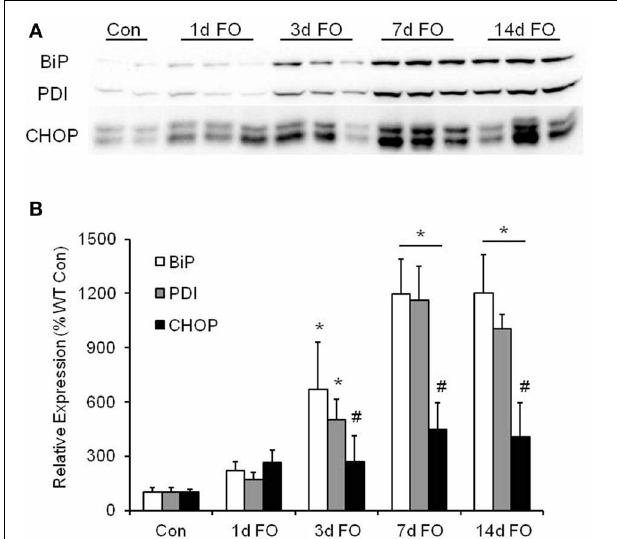
FIGURE 3 | Markers of endoplasmic reticulum (ER) stress are higher in the plantaris muscle following functional overload (FO). (A) Representative western blot of ER stress markers BiP, PDI, and CHOP in WT mice after no treatment (Con) and 1, 3, 7, and 14 days of FO. (B) Quantification of the western blots for BiP (open bars), PDI (gray bars), and CHOP (black bars). A ponceau stain of the membrane was used to normalize protein expression. Data are expressed as a percentage of the respective control value for each protein (mean ± SD , n = 4–6/group). ∗ P < 0 . 05 vs. control expression for each protein, # P < 0 . 05 CHOP vs. BiP, or PDI at given time